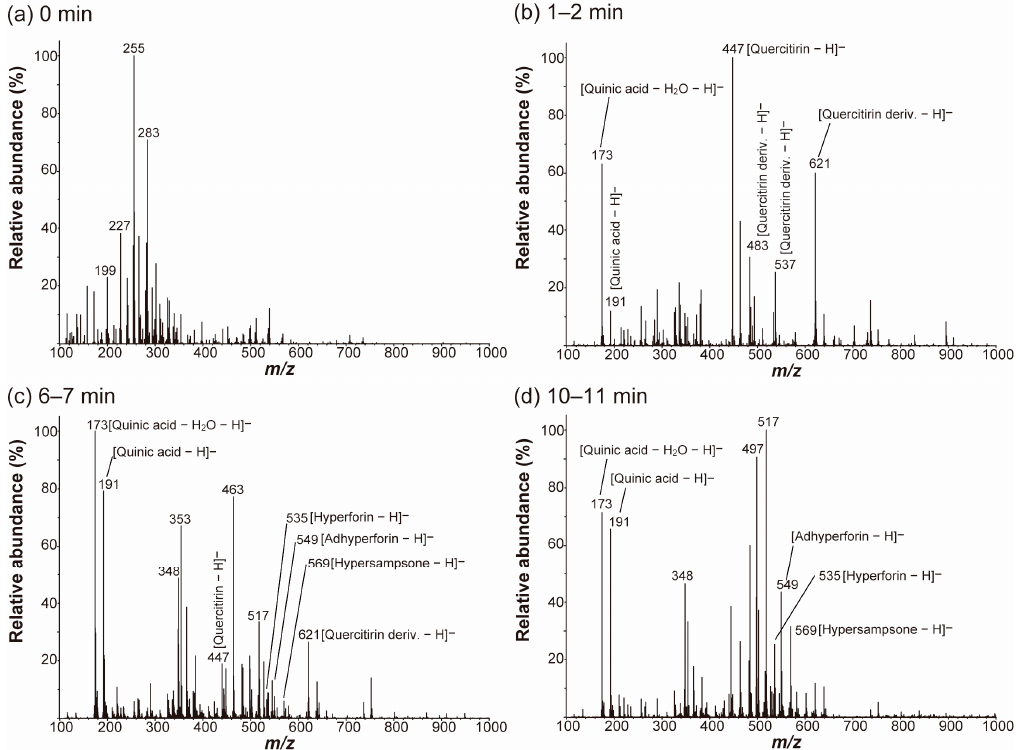
Figure 2. Time-segmented and averaged mass spectra of a Hypericum leaf obtained by nano-DESI MS in the negative ion mode. ( a ) 0 min, ( b ) 1–2 min; ( c ) 6–7 min; ( d ) 10–11 min. The spraying solvent was EtOH. The abbreviation “deriv.” denotes “derivative”.